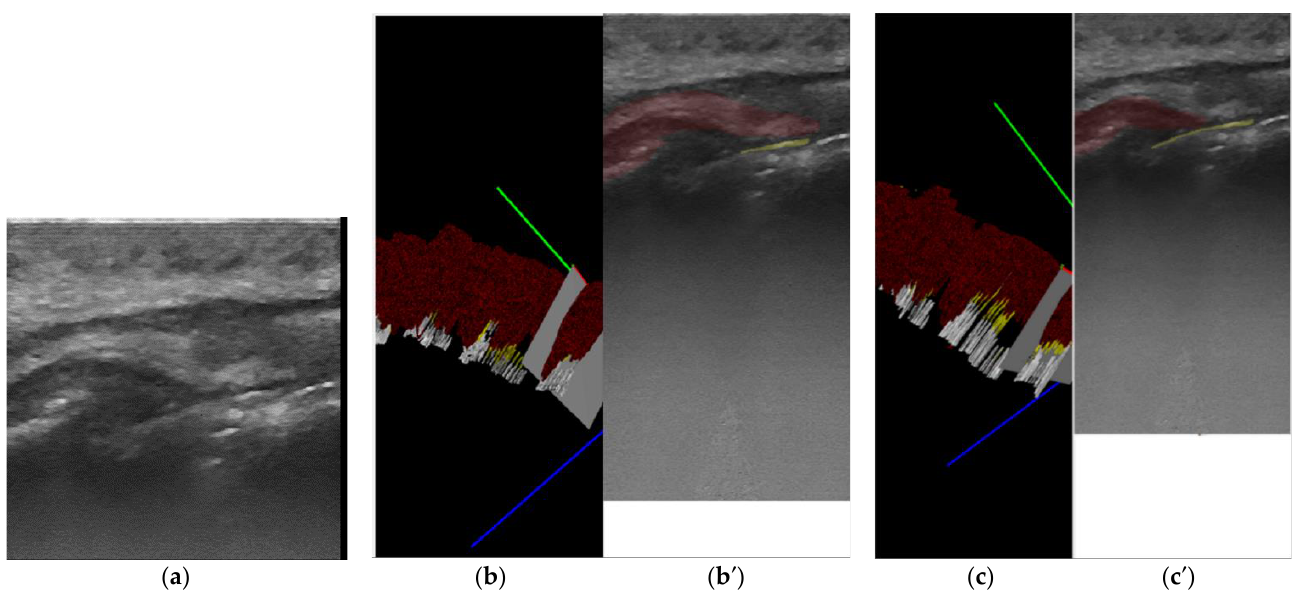
Figure 2. ( a ) 1.4, first upper right premolar, longitudinal section of the marginal periodontal tissue, buccal surface original US image, gray scale; ( b ) 3D visualization: red, green, blue lines — cross-sec- tioning plane direction on the 3 axes; ( b ′ ). first semi-automatic segmentation: white — tooth crown, yellow tooth root, dark red — gingiva, light red — cortical bone; ( c ) 3D visualization using corrected masks; ( c ′ ) segmentation after correction: white — tooth crown, yellow tooth root, dark red — gingiva, light red — cortical bone.